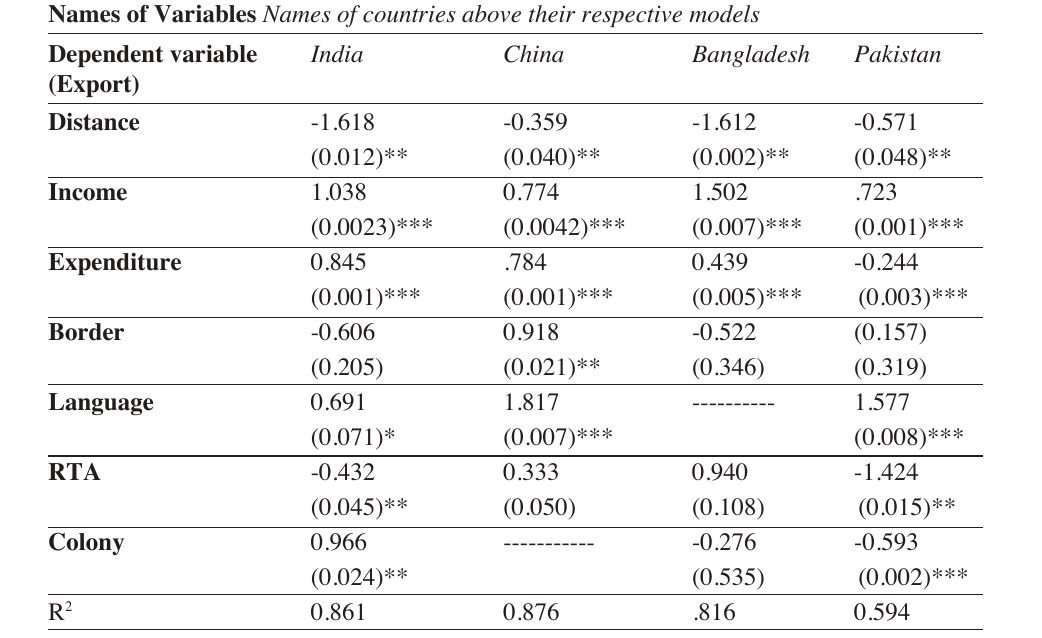
TABLE-3 Four Gravity models estimated